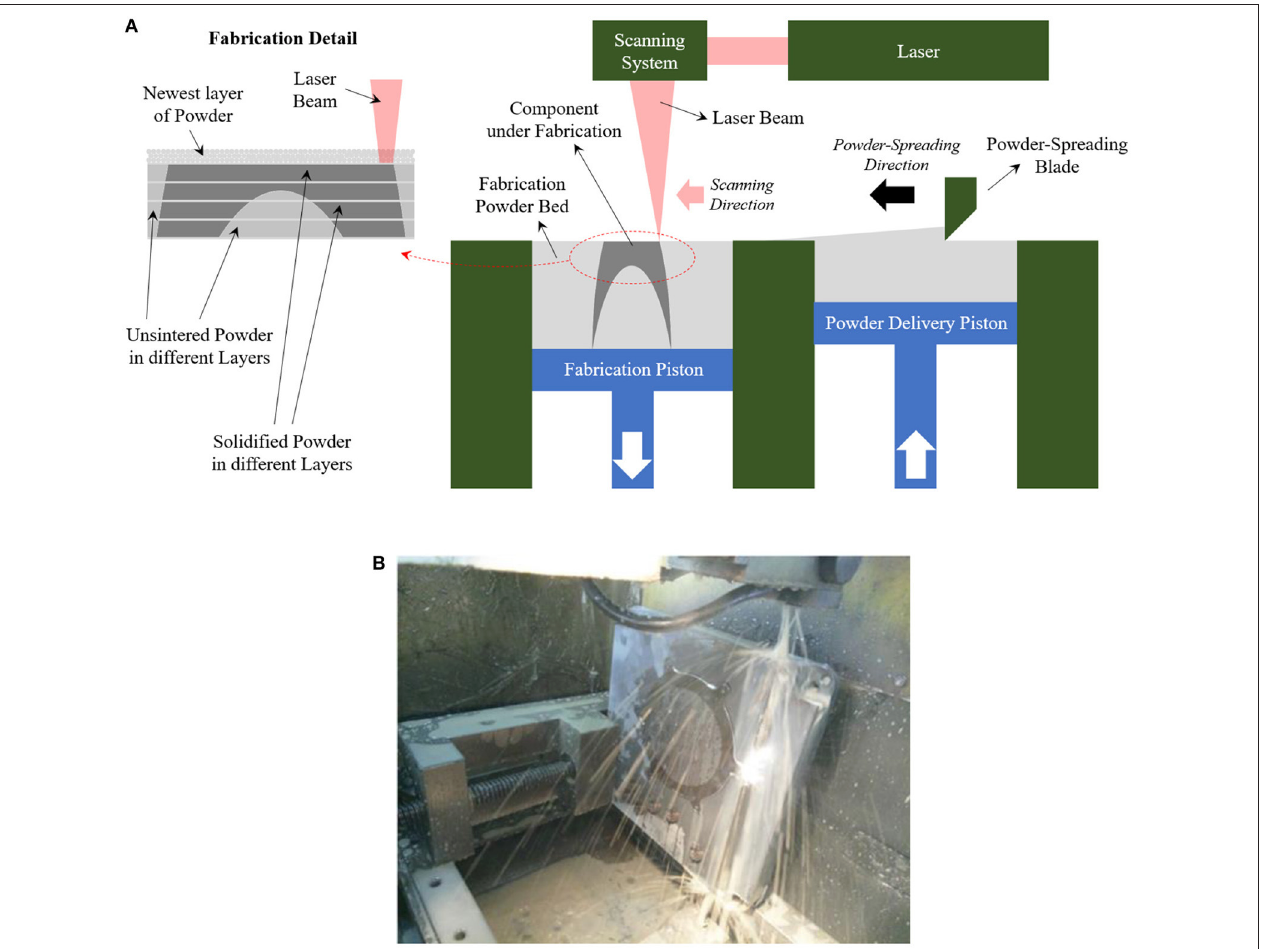
FIGURE 1 | (A) Illustration of the SLM process and (B) Beginning of build platform/grid separation